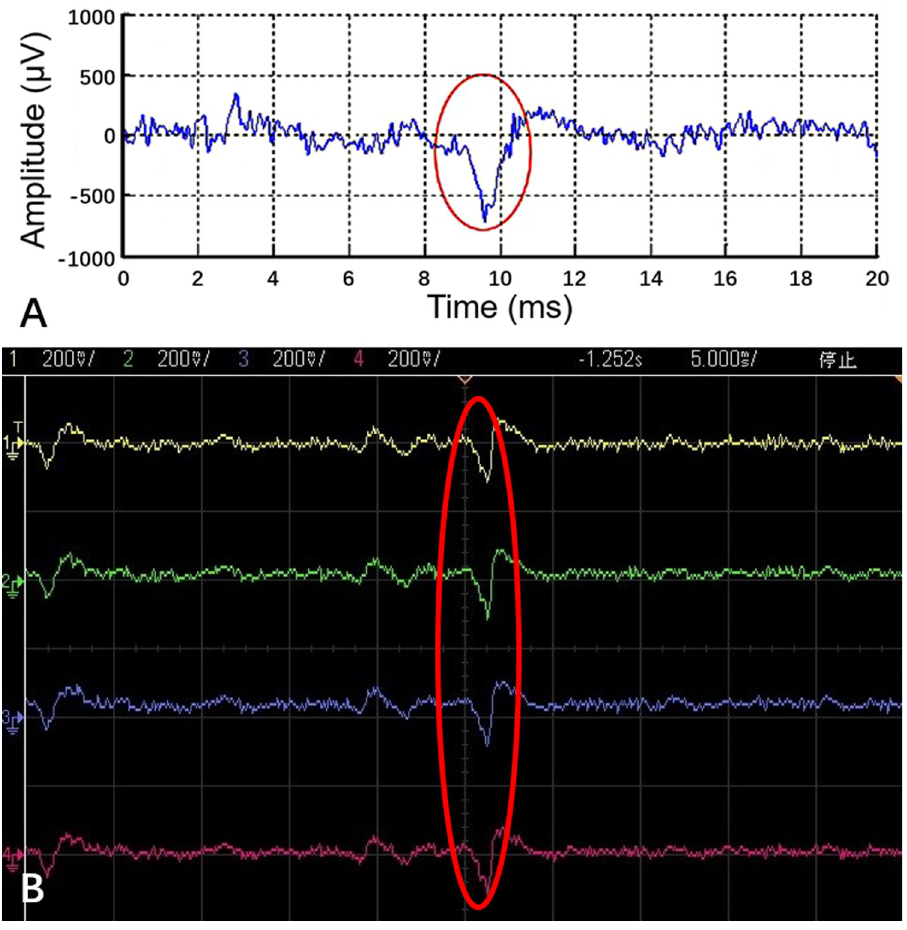
Fig 2. The signals of typical triggered responses of PC12 quasi-neuronal networks. A) The responses recorded by the neuro signal processor and the curve was plotted by MATLAB. B) The amplified responses recorded by 4 different channels were displayed on the oscilloscope. The peak-to-peak voltage of the stimulation was 40 mV at the time.